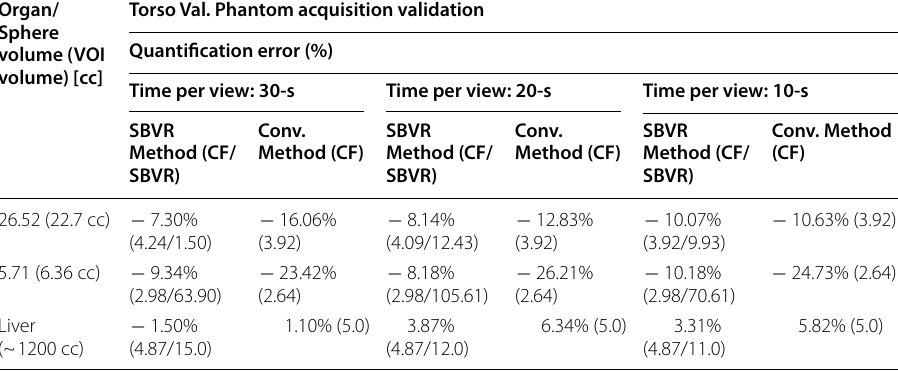
Table 4 Quantification errors between activity concentrations calculated with the conventional method and the SBVR method for different time per view settings for spheres and liver in the Torso Phantom (minus sign – overestimation)